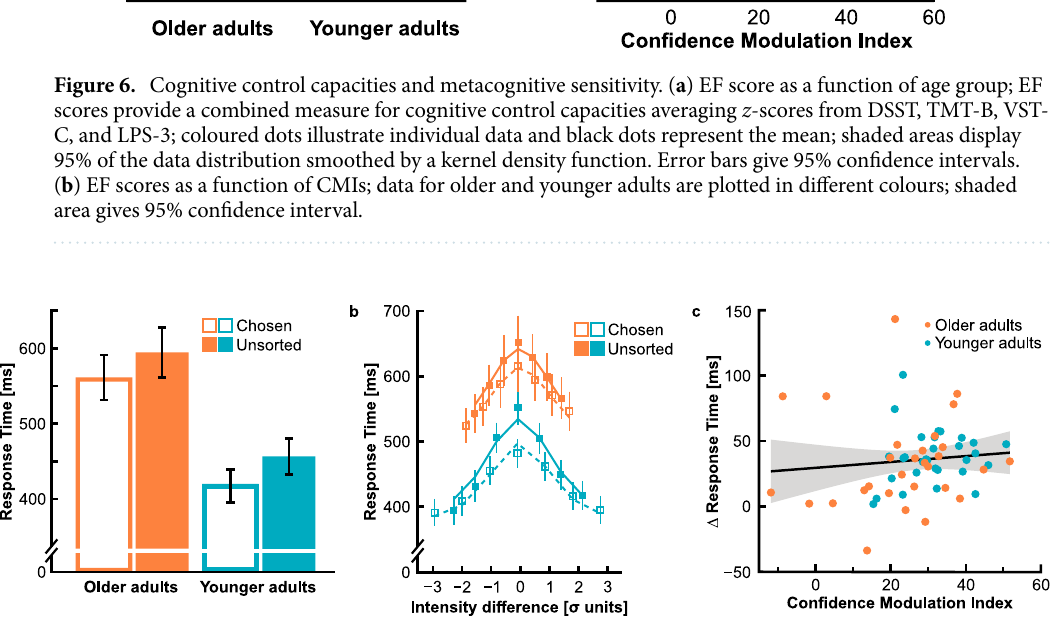
Figure 7. Response times (RT). ( a ) Average RTs as a function of age group and confidence set; open bars illustrate data from the chosen confidence set, closed bars represent data from the unsorted confidence set. ( b ) RTs for bins of stimulus intensities, i.e., contrast difference between test and standard patches, given in standard deviation units of the psychometric function (see “Methods”); symbols represent average group data, lines represent the average fitted data; dashed lines and open symbols represent data from the chosen trial set, solid lines and closed symbols represent data from the unsorted trial set; colour code for age groups corresponds to ( a ). ( c ) RT differences between the unsorted and the chosen confidence sets as a function of CMIs; data for older and younger adults are plotted in different colours. Error bars and shaded areas give 95% confidence